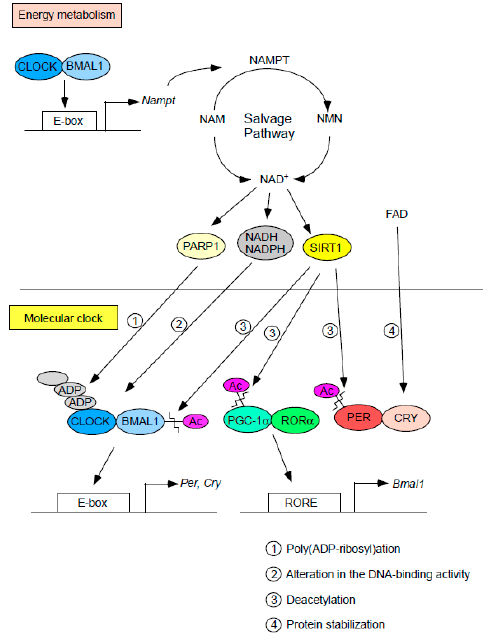
Figure 2. Interplay between cellular redox factors and the molecular clock. Cellular redox status directly and indirectly affects the function of the molecular clock through changes in the levels of cofactors (i.e., NADH, NADPH, and FAD) and/or the activity of NAD + -consuming enzymes (SIRT1 and PARP1). The molecular clock in turn regulates the transcription of the Nampt gene, which encodes the rate-limiting enzyme in the NAD + salvage pathway.